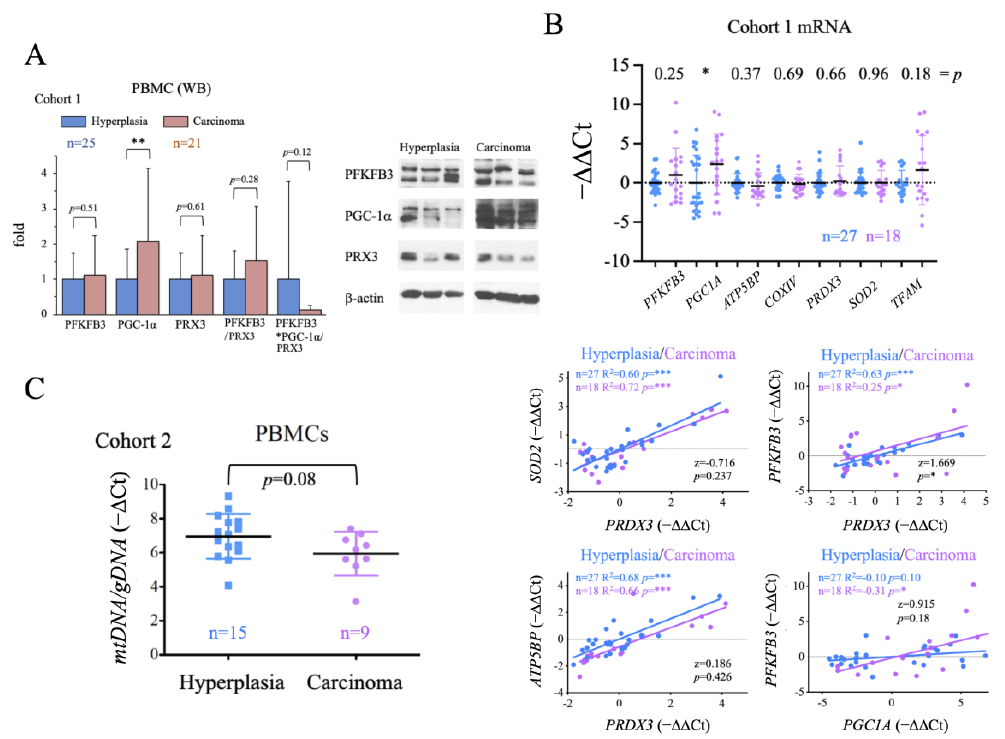
Figure 3. PBMCs from thyroid cancer patients have higher levels of PGC-1 than those from patients with hyperplasia. ( A ) Western blot data analysis of key metabolic regulators (PGC-1 α , PFKFB3 and PRX3) in PBMCs. ( B ) qRT-PCR analysis of metabolism-related genes in PBMCs, the top panel shows the − ∆∆ Ct values and the bottom panel shows the correlation and linear regression of the indicated genes. ( C ) qPCR determination of mtDNA copy number in PBMCs. Data are mean ± standard deviation (SD). *, p < 0.05; **, p ≤ 0.01, ***, p ≤